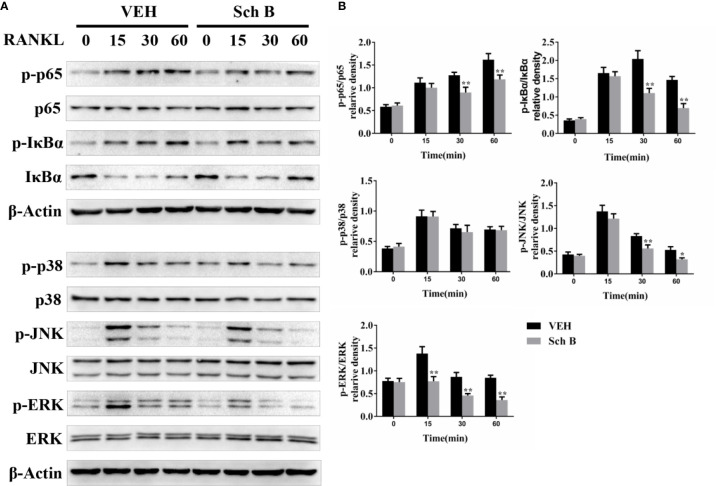
Schisandrin B represses receptor activator of nuclear factor-κB ligand (RANKL)–induced NF-κB and mitogen activated protein kinase (MAPK) activation. (A, B) BMMs were starved in 0.5% FBS complete medium for 12 h. Then the cells were pretreated with or without Schisandrin B (20μM) for 24 h. Before the collection of protein extracts, BMMs were stimulated with RANKL for 0, 15, 30, or 60 min. The components of NF-κB and MAPK signaling pathways were measured by Western blotting. The data were confirmed by three independent experiments and are expressed as means ± SD. *P < 0.05, **P < 0.01 versus the vehicle.